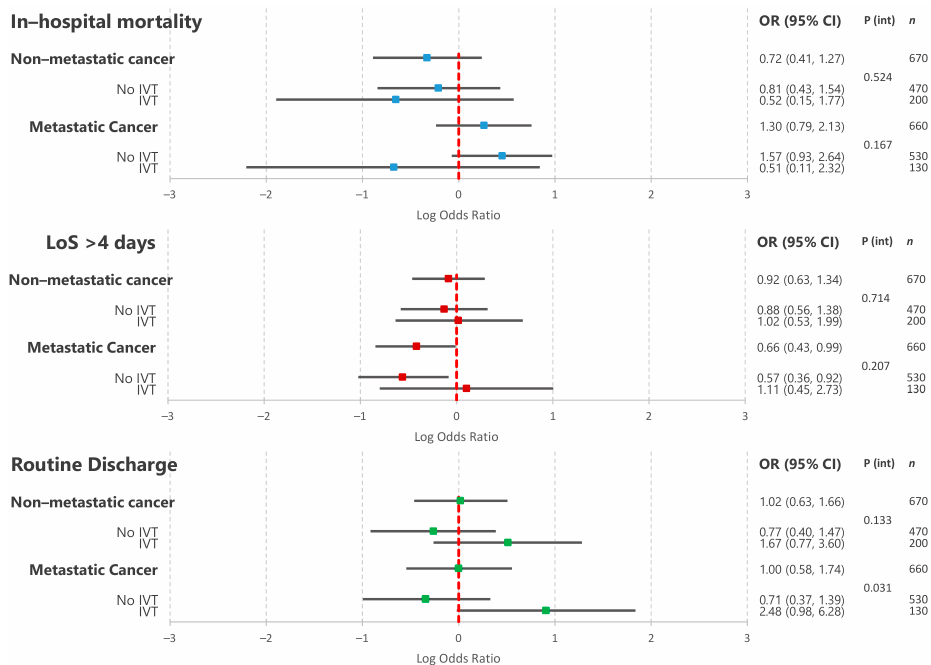
Figure 4. Results of multivariable logistic regressions assessing the association between co-morbid cancer (non-metastatic and metastatic) and acute ischaemic stroke in-hospital outcomes amongst AIS patients undergoing endovascular thrombectomy. Separate models containing interaction terms with intravenous thrombolysis therapy were constructed to deter- mine whether outcomes were modified by IVT pre-treatment. OR—odds ratio; CI—confidence interval; IVT—intravenous